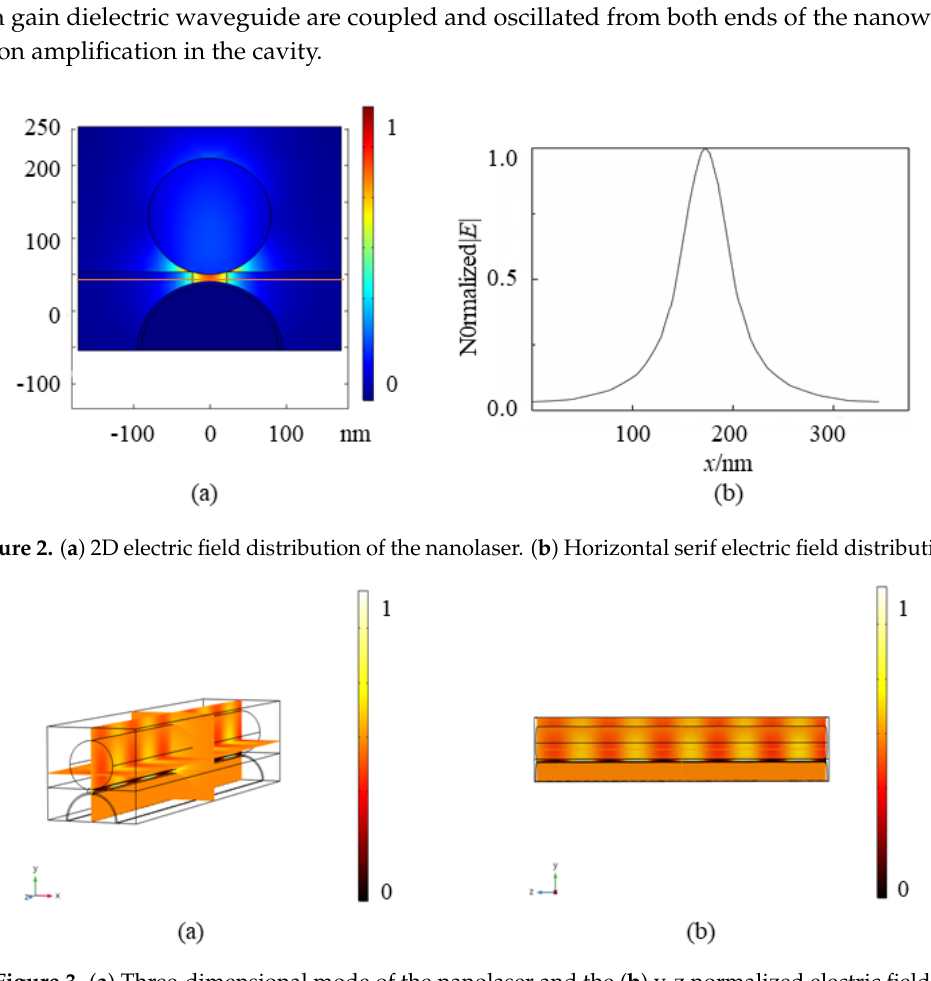
Figure 3. ( a ) Three-dimensional mode of the nanolaser and the ( b ) y-z normalized electric field.